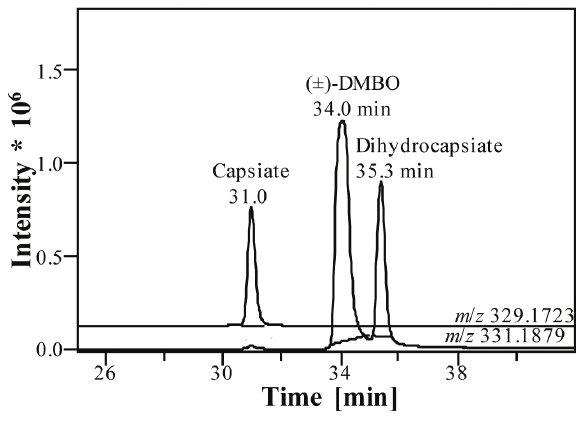
Figure 6: HPLC-ESI-MS(QTOF) chromatograms of capsiate, (±)-DMBO and dihydrocapsiate standards . Ion chromatograms were extracted for the exact m / z values corresponding to the [M+Na] + species of capsiate, (±)-DMBO and